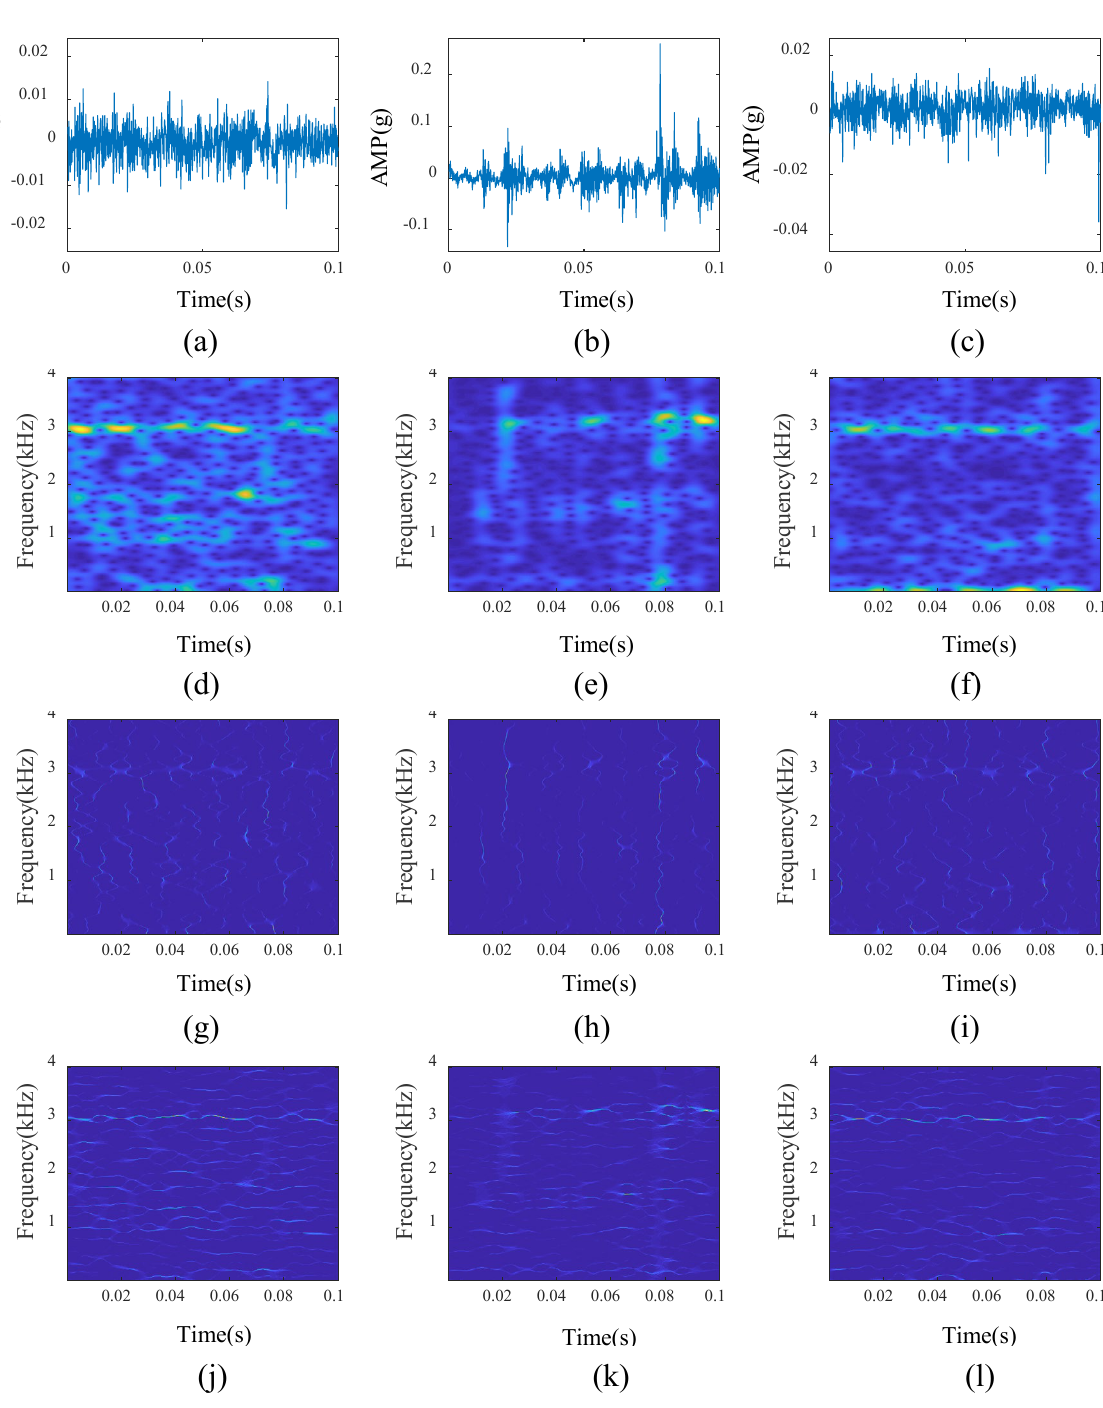
Figure 4. Time–frequency images of vibration signal of rolling bearing: ( a – c ) are time–domain waveforms of normal, inner race fault and outer race fault samples respectively; ( d – f ) are STFT time-frequency images corresponding to ( a – c ) respectively; ( g – i ) are TMSST time-frequency images corresponding to ( a – c ); ( j – l ) are MSST time-frequency images corresponding to ( a – c )